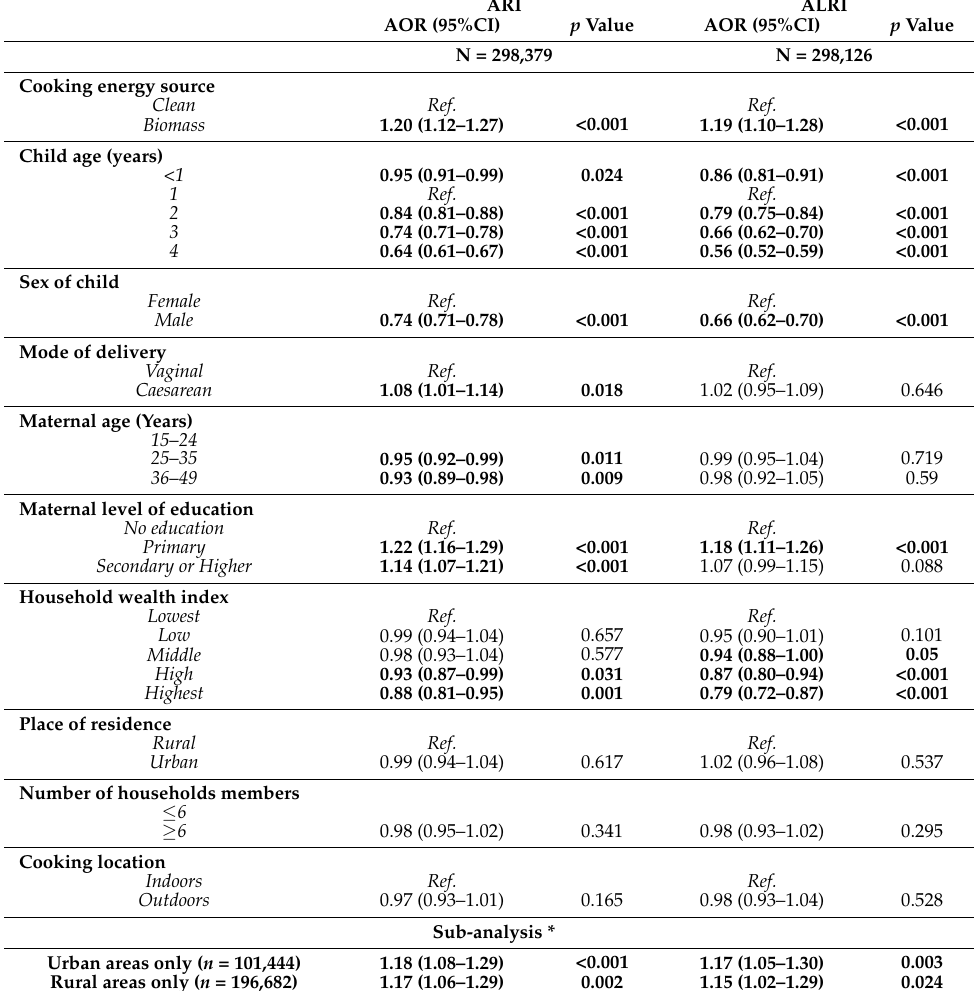
Table A3. Adjusted odds ratio (AOR) with 95% CI for the association of ARI and ALRI in children aged under five years with biomass cooking compared to cleaner cooking, where kerosene is classified as a cleaner energy